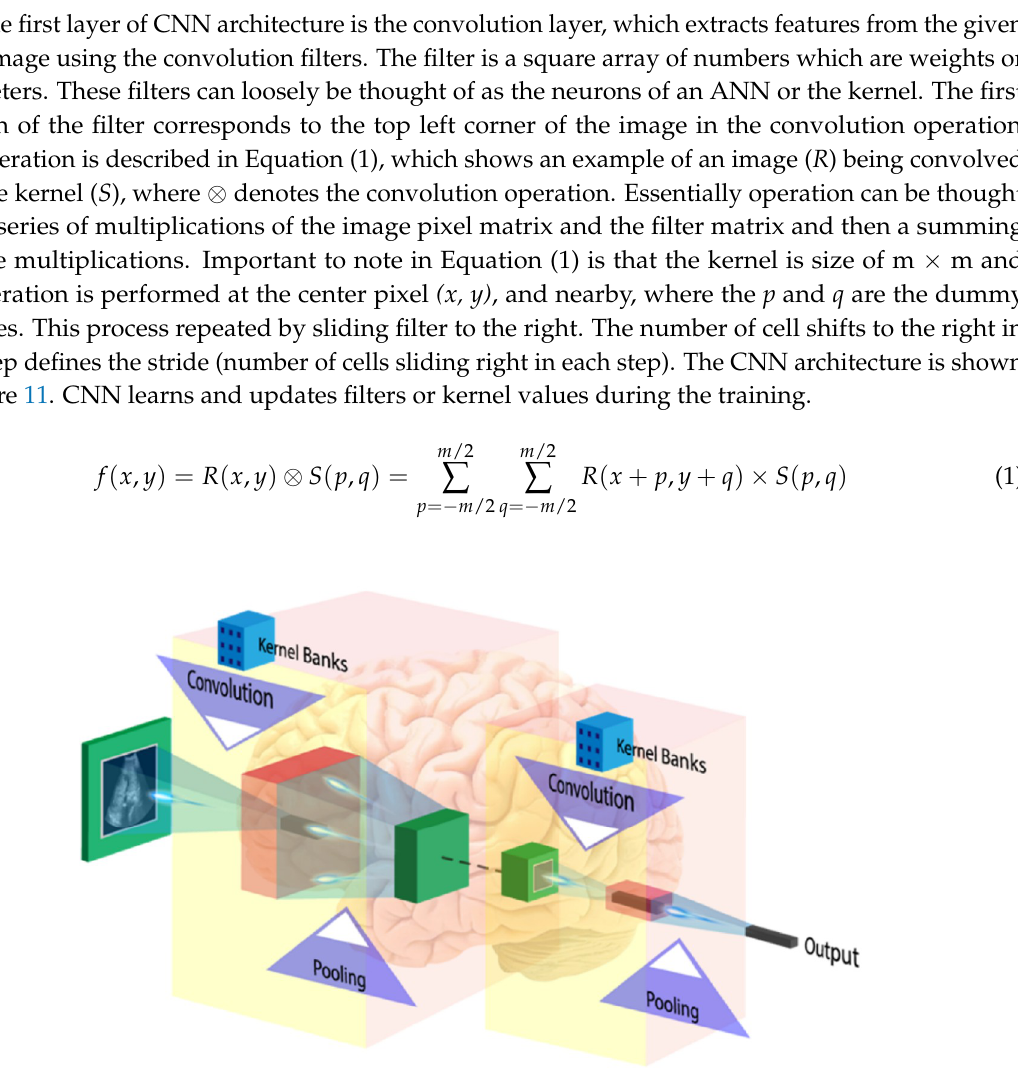
Figure 11. CNN architecture (image courtesy: AtheroPoint TM ).